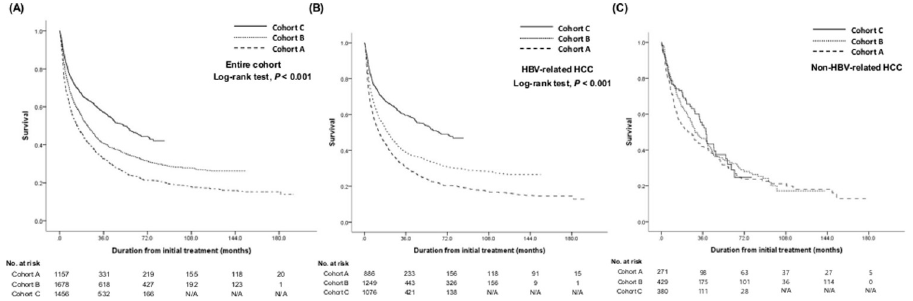
Fig 2. Survival of patients according to the subgroups in entire cohort (A), in patients with HBV etiology (B), and non-HBV etiology